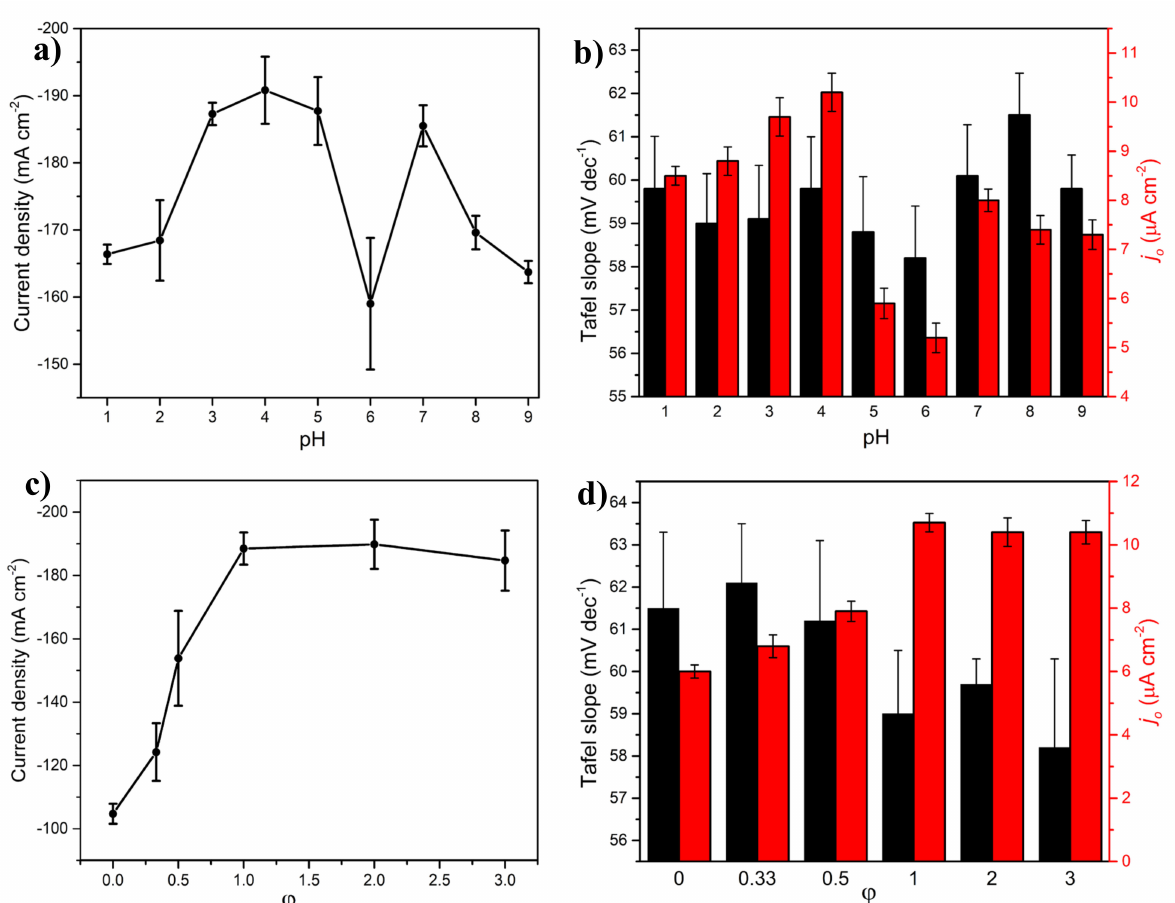
Figure 4. Dependence of the HER current density on the ( a ) pH of the precursor solution and ( c ) Figure 3. ratio ( ϕ ). The electrocatalyst layer consisted of NiMoO 4 , carbon black, and